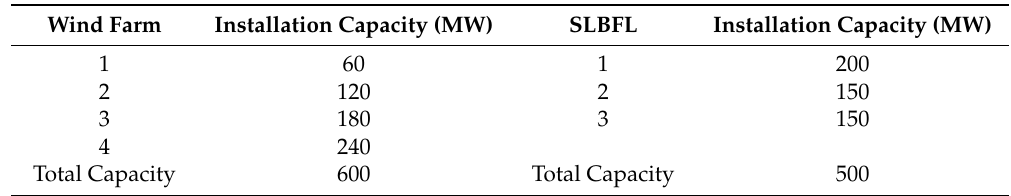
Table 1. Installed capacity of wind farms and SLBFLs.